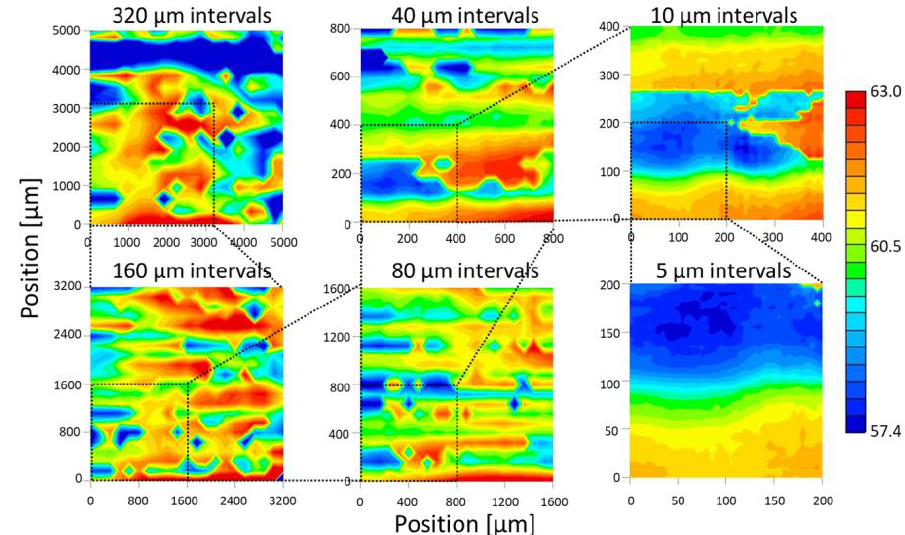
Figure 4. Pretilt angle mapping per measurement range.